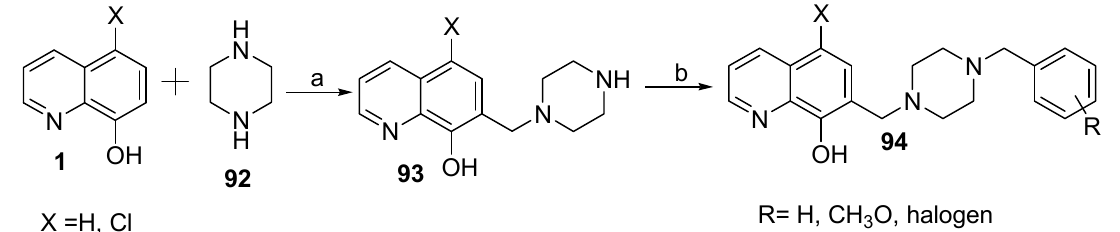
Scheme 22. Synthesis of new derivatives of